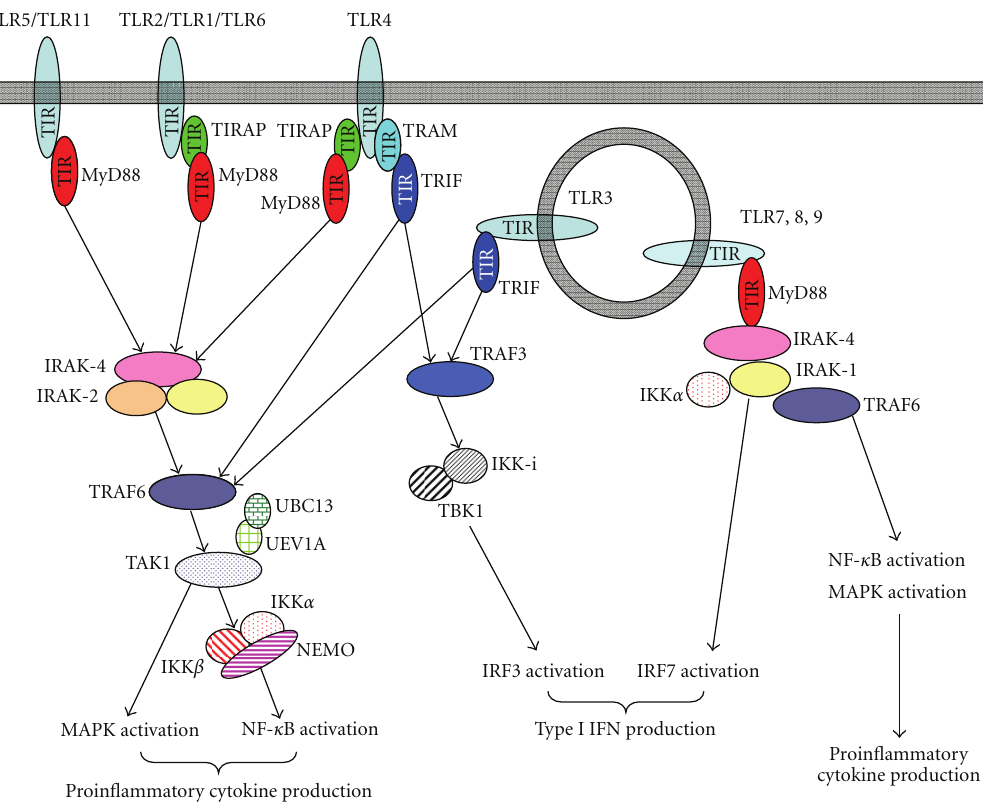
Figure 2: TLR-mediated MyD88-dependent or TRIF-dependent pathways. TIR domain-containing adaptors MyD88, TIRAP, TRIF, and TRAM define TLR-mediated signaling. MyD88 and TIRAP are adaptors for the MyD88-dependent pathways, which mainly activate proinflammatory cytokine production. On the other hand, TRIF and TRAM are adaptors for IRF3 activation, resulting in production of type I IFN by TLR3- or TLR4-mediated TRIF-dependent pathways. In pDCs, TLR7/TLR9-mediated MyD88-dependent pathways induce IRF7 activation, leading to IFN α